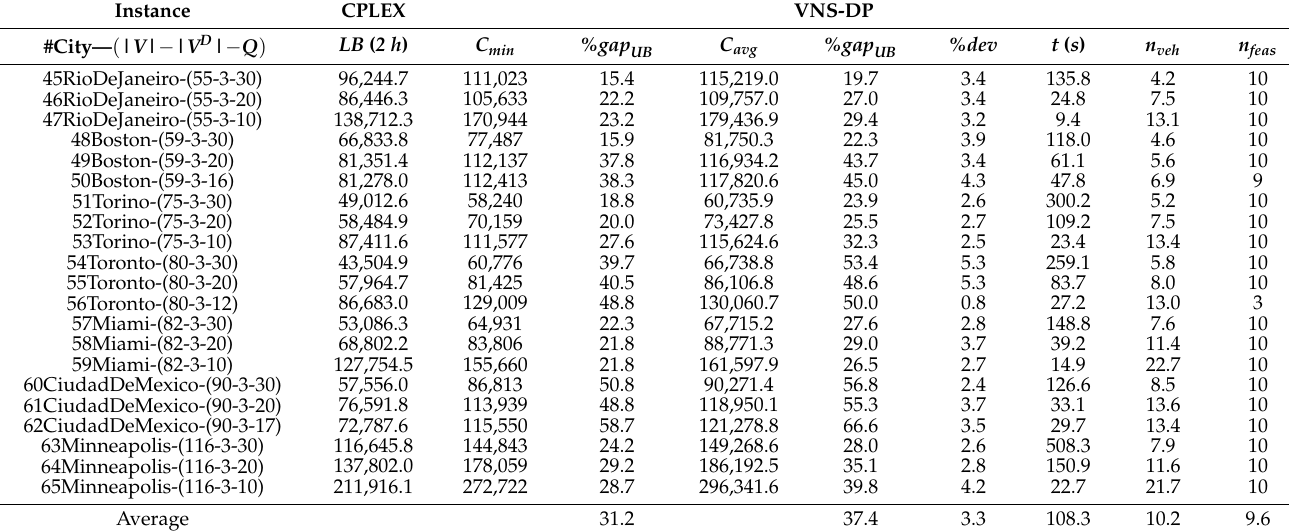
Table 6. Results for large-size benchmark